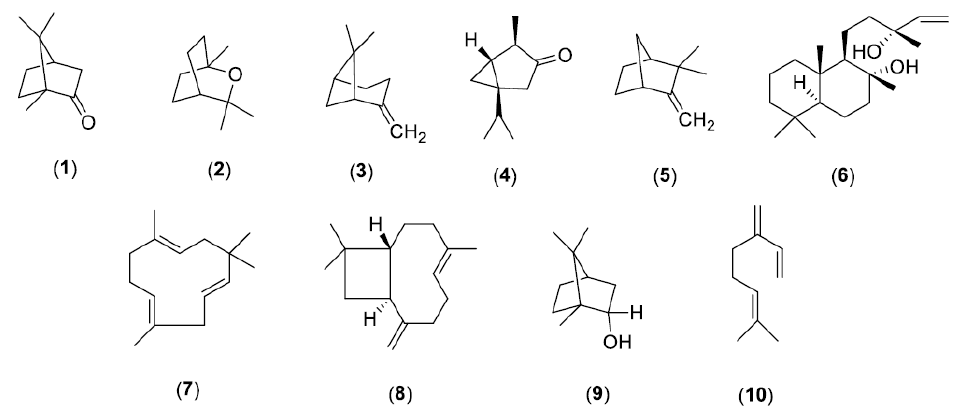
Figure 1. The chemical structure of the most abundant constituents of S. officinalis EO, camphor ( 1 ), 1,8-cineole ( 2 ), β -pinene ( 3 ), α -thujone ( 4 ), camphene ( 5 ), sclareol ( 6 ), α -humulene ( 7 ), trans-caryophyllene ( 8 ), borneol ( 9 ), and myrcene ( 10 ).